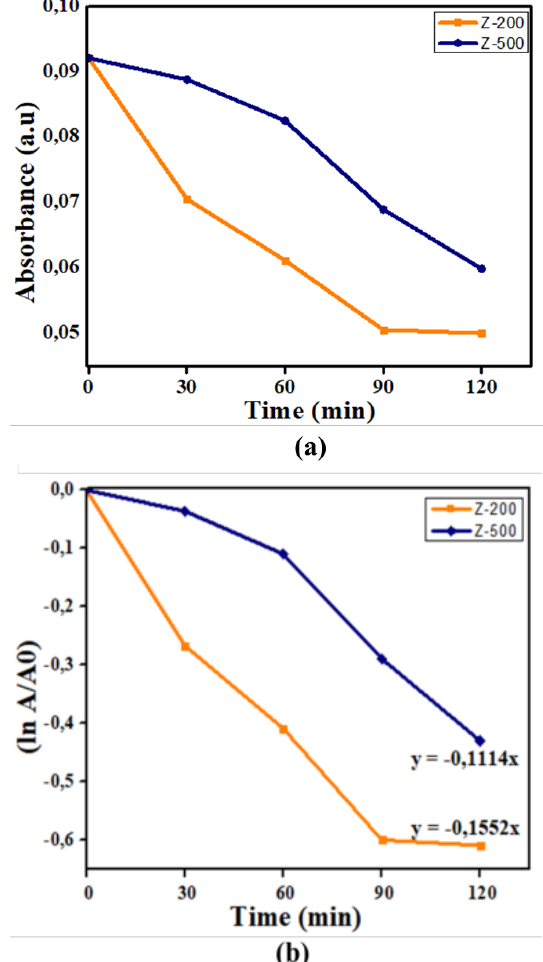
Fig. 6. (a) Absorption curve of MB at λ = 662 nm (b) Graph of ln A/A0 versus degradation time